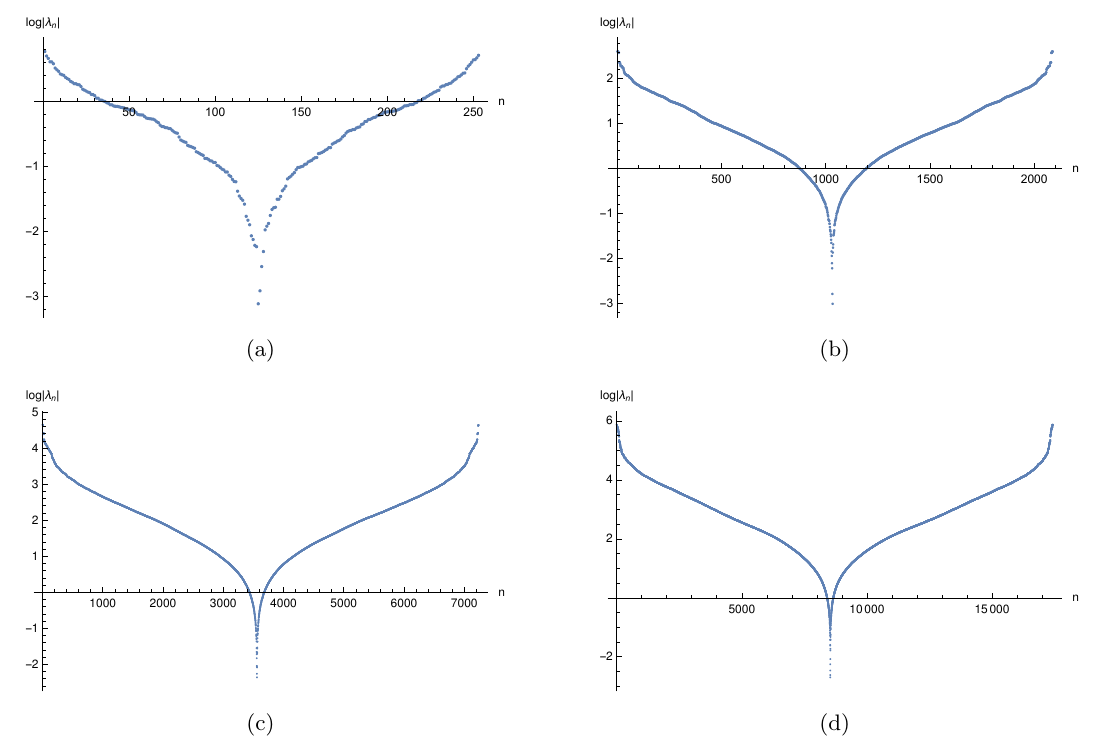
Figure 5 . The eigenvalues of ^ H whose eigenstates have nonzero projection to V . The x -axis is a label of the eigenvalues sorted in the ascending order, and the y -axis denotes logarithm of the absolute magnitude of eigenvalues. The eigenvalues on the left (right) of the dip are negative (positive). The Hamiltonian has been numerically diagonalized for N = 3 by discretizing the compact space of each (cid:30) a into L segments, where (a) L = 12, (b) L = 24, (c) L = 36, (d) L = 48. With increasing L , the bandwidth of the eigenvalues keeps increasing, which re(cid:13)ects the fact that the spectrum is unbounded both from the above and below in the continuum limit. On the other hand, the eigenvalue that is smallest in magnitude saturates to a nonzero value. This suggests that there is no state in V with zero energy in the continuum